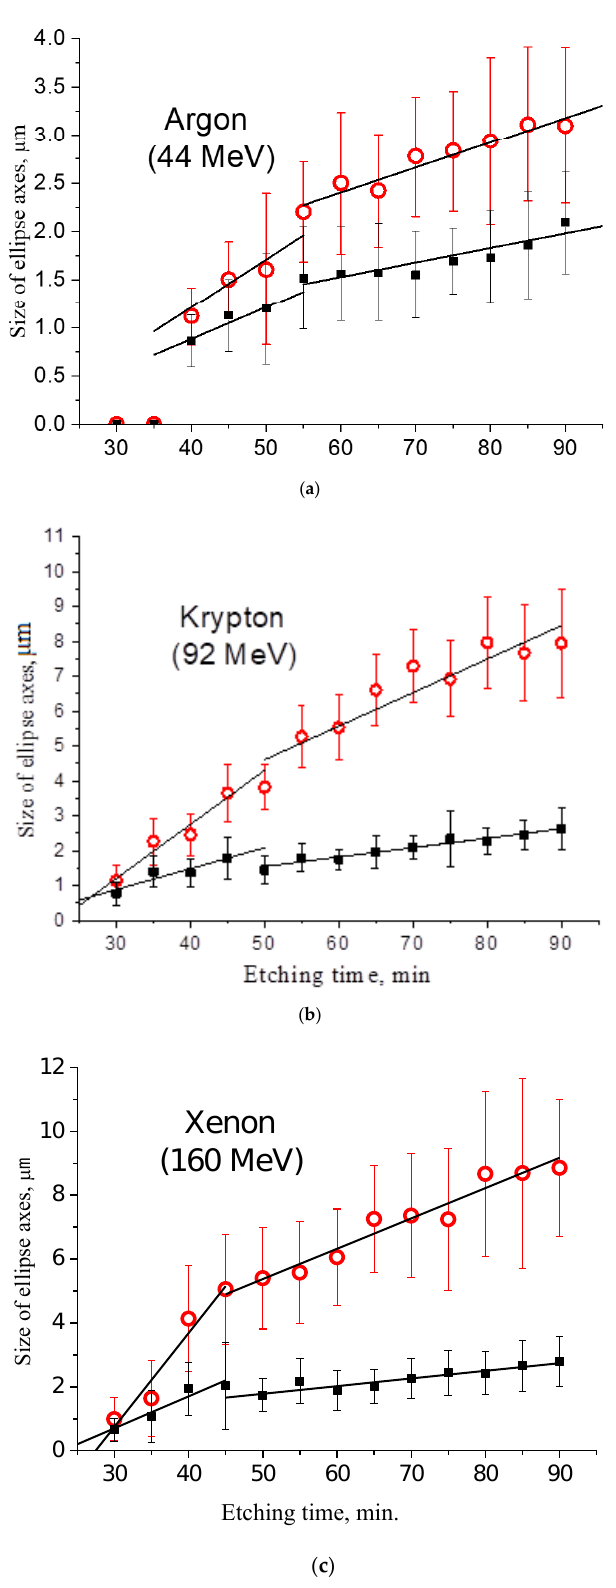
Figure 3. Dependence of the large (red points) and small (black points) ellipse axes on the glass surface on the etching duration for different ions (( a )—Argon, ( b )—Krypton and ( c )—Xenon). The beam inclination angle is 30° to the glass surface (Color).